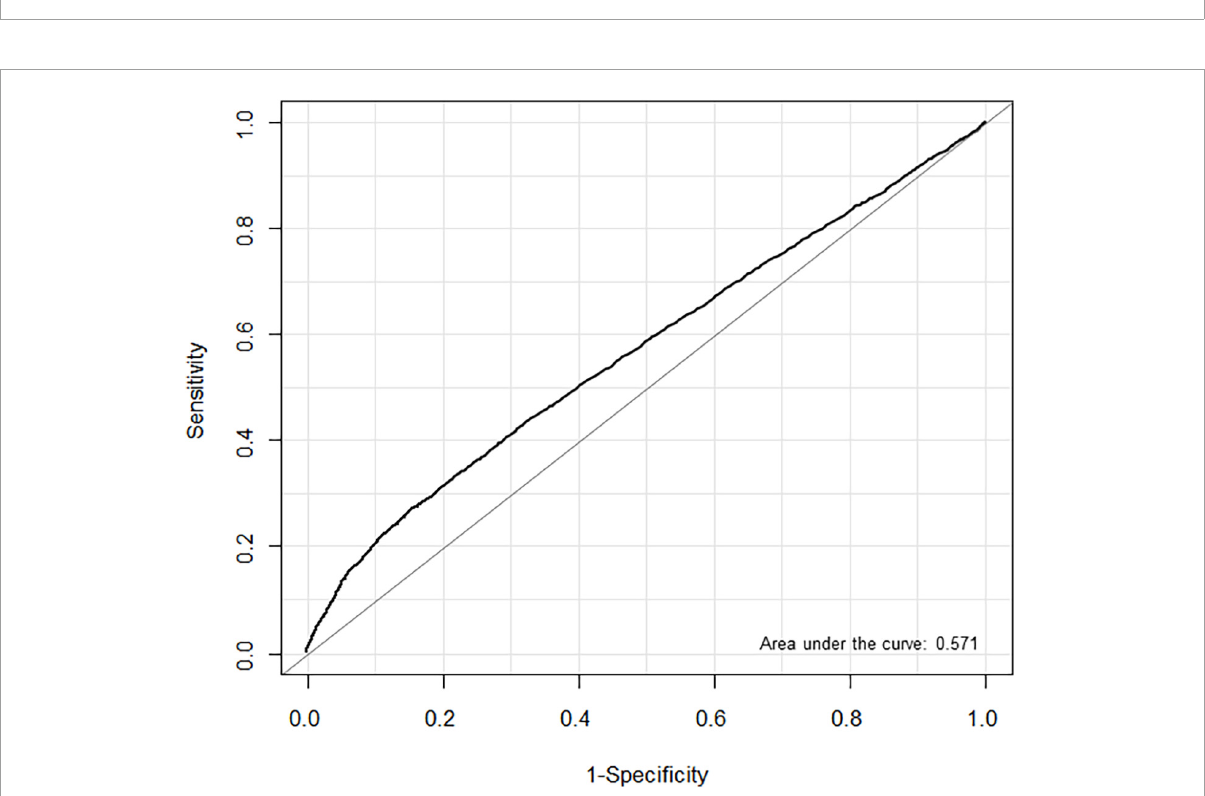
FIGURE3 Receiver operating characteristic (ROC) curves for left atrial volume index (LAVI) associated with postoperative atrial fibrillation (POAF) in non-cardiac surgery.